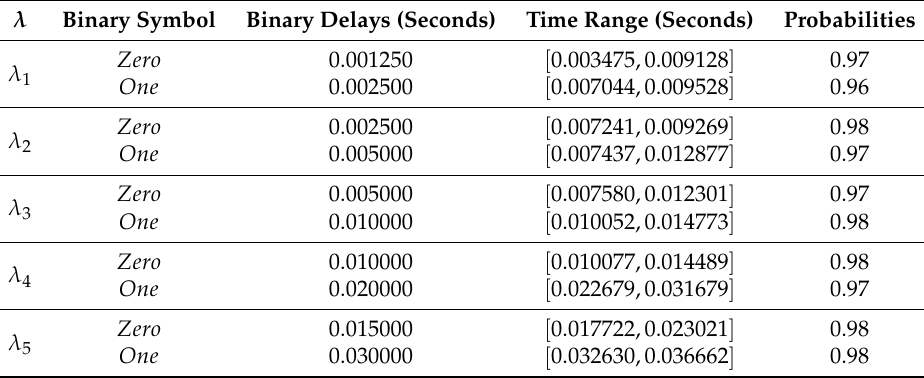
Table 4. Time ranges of binary covert packets in network configuration 1.